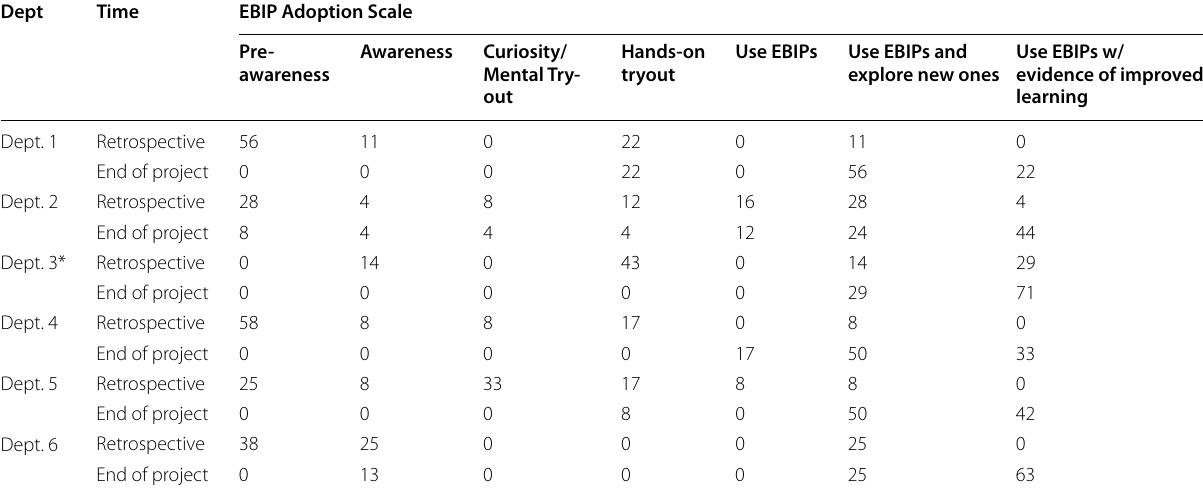
*Two respondents from this department did not complete the EBIP scale so the sample size for this item is two less than what is reported in all other